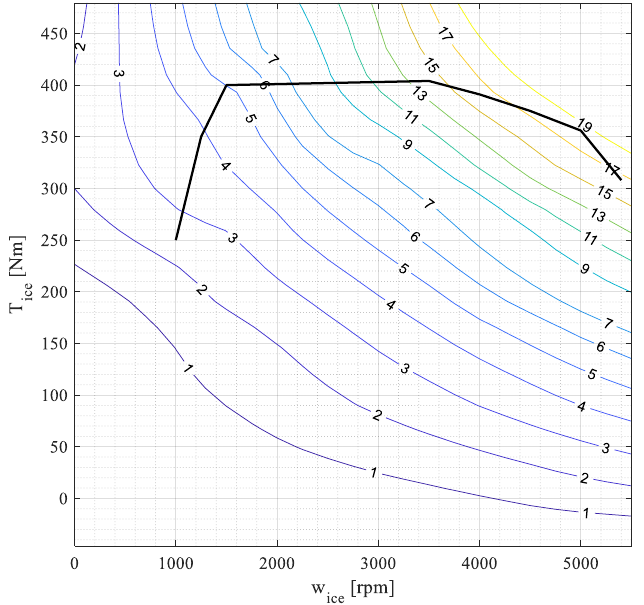
Figure 2. Fuel consumption map of Mazda CX9 2016 internal combustion engine obtained in steady- state conditions [18].